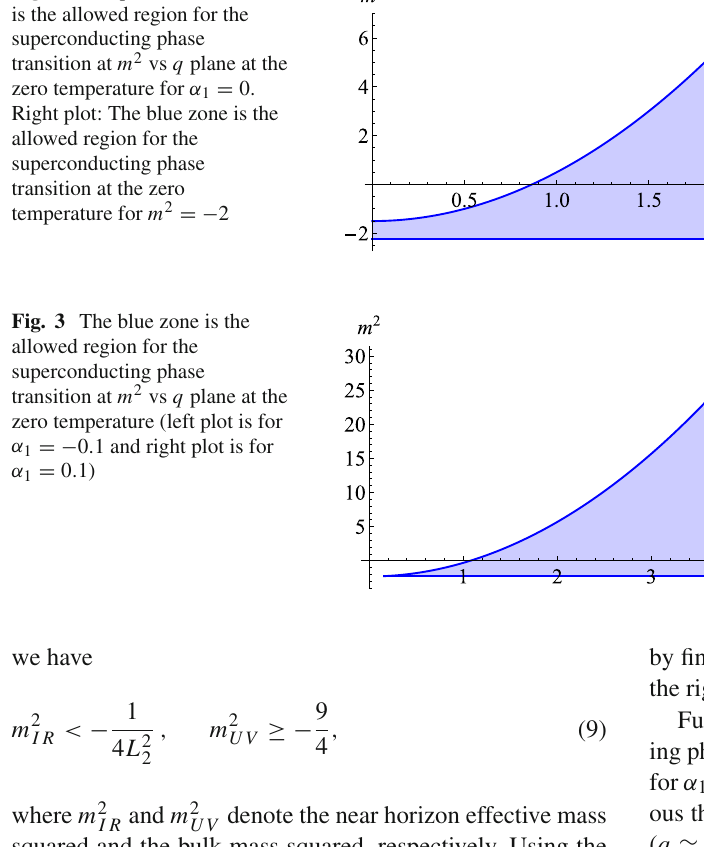
Fig. 2 Left plot: The blue zone is the allowed region for the superconducting phase transition at m 2 vs q plane at the zero temperature for α 1 = 0. Right plot: The blue zone is the allowed region for the superconducting phase transition at the zero temperature for m 2 = − 2